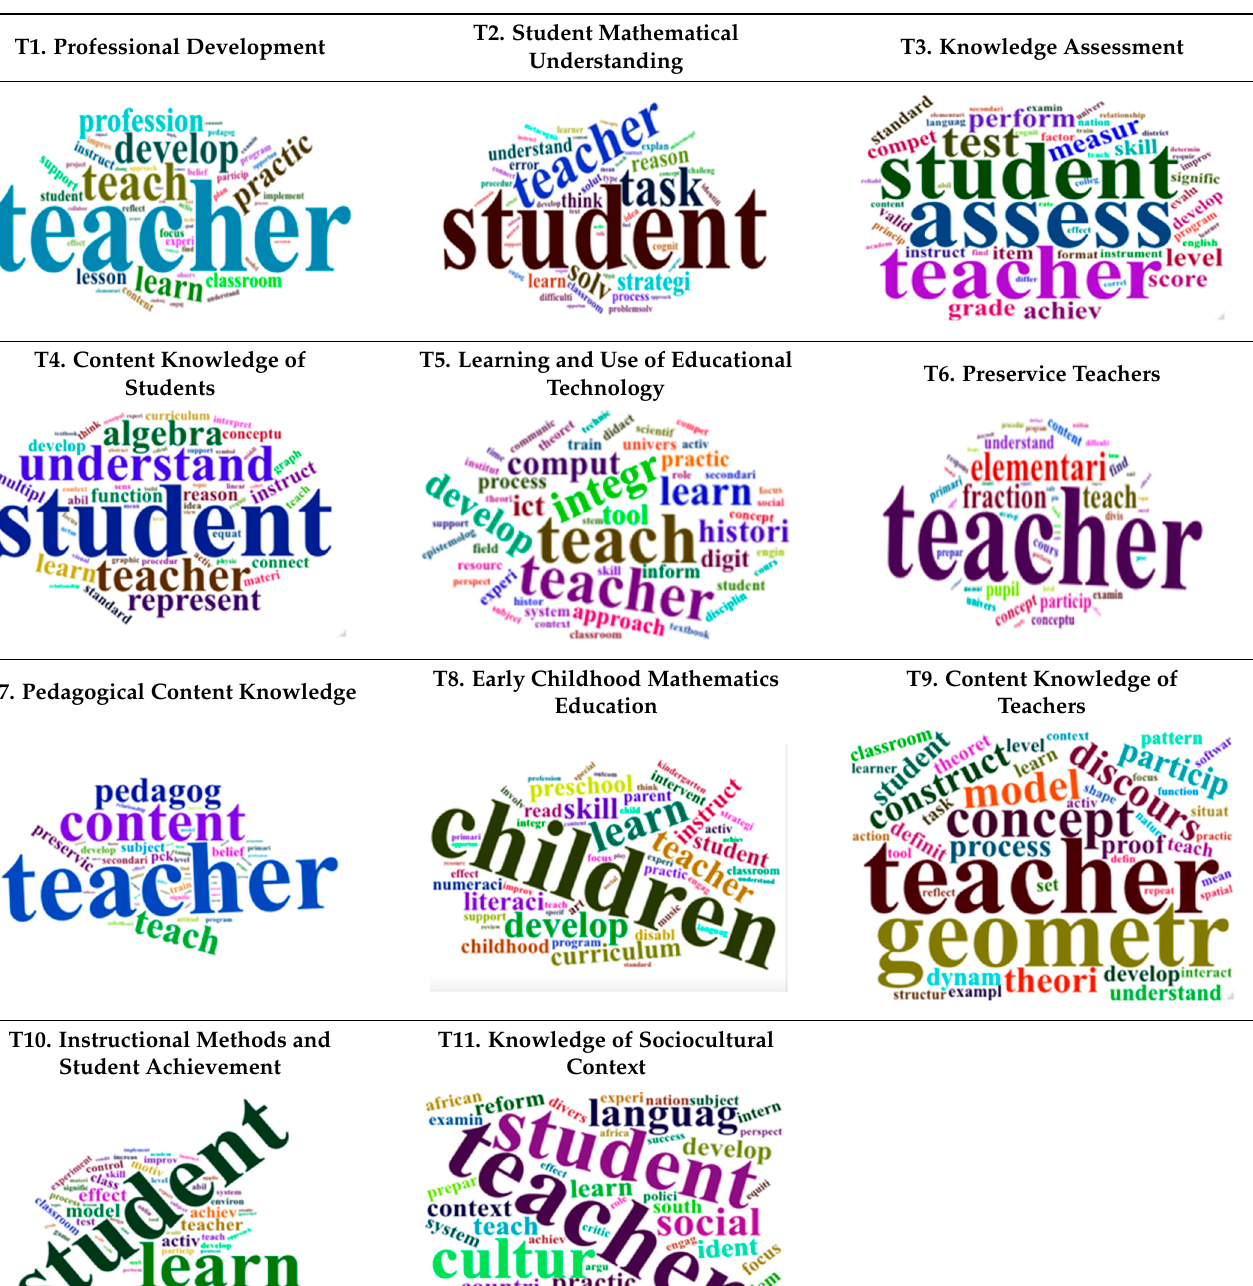
Table 5. Word clouds of each topic.